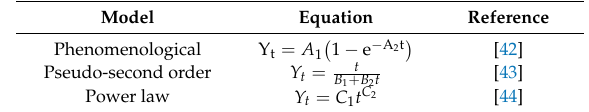
Table 1. Theoretical kinetic models for the extraction of flavonoids in Mairei Yew